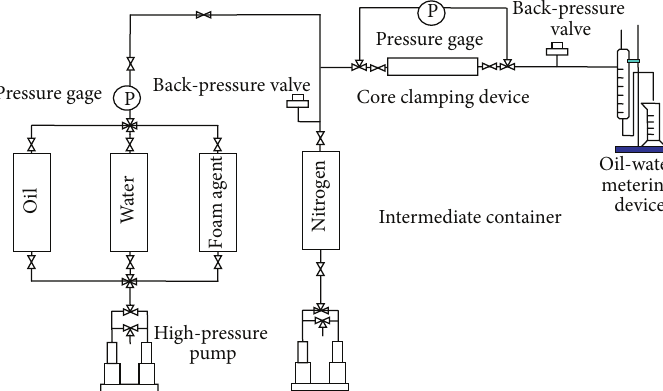
Figure 1: Schematic diagram of the foam displacement and flow control instruments.